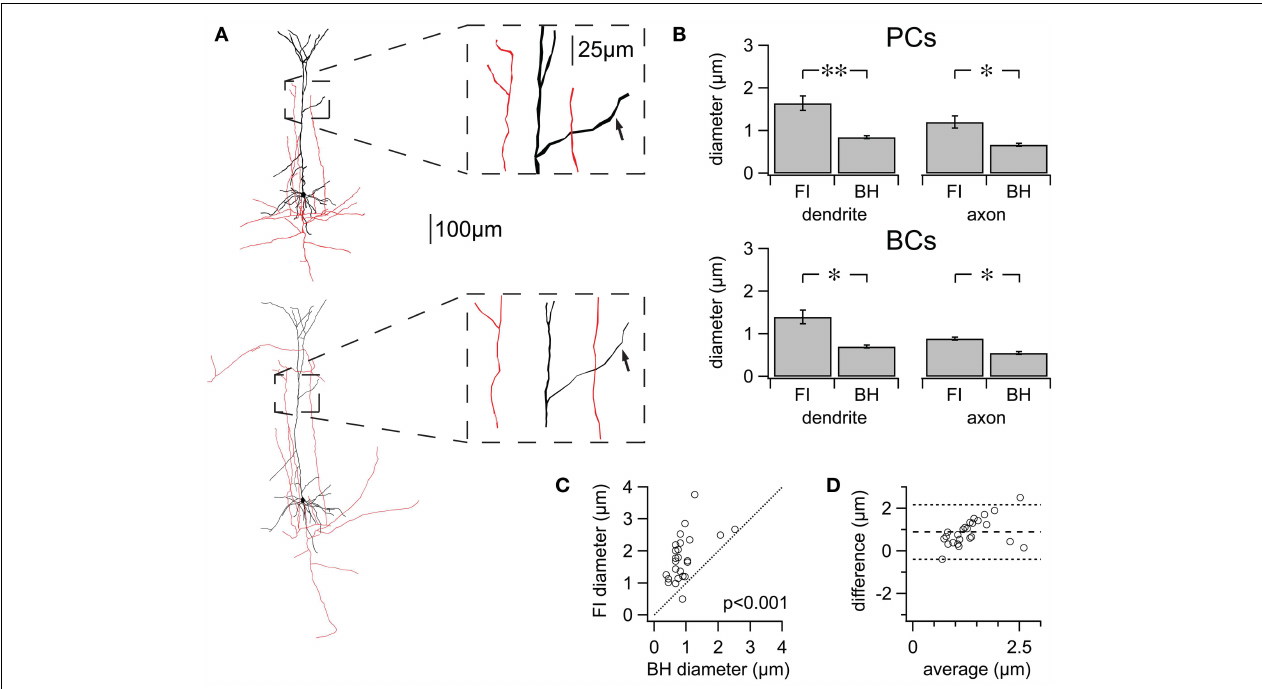
matched measurements were plotted above the line of equality, reflecting the tendency of FI reconstructions to have larger process diameter (PCs; n = 5 cell pairs; n = 25 segment pairs; FI vs. BH Diameter; mean 1.80 ± 0.15 µ m vs. 0.91 ± 0.09 µ m; p < 0 . 001). (D) The degree of agreement between the two methods is ascertained using a Bland-Altman or Tukey mean-difference plot (Bland and Altman, 1986). FI diameter—BH diameter is plotted against averaged process diameters, (FI + BH diameter)/2. Middle dotted line indicates a positive mean difference (0.89 ± 0.13 µ m), showing that FI reconstructions consistently suffer from exaggerated process diameters. The upper and lower dotted lines indicate ± 2SD and the 95% limits of agreement ( SD = 0 . 64 µ m). Linear regression (not shown) identified a significant slope (0.56; p < 0 . 05), showing that FI reconstruction overestimates diameters more for larger diameters. ∗ p < 0 . 05, ∗∗ p < 0 .